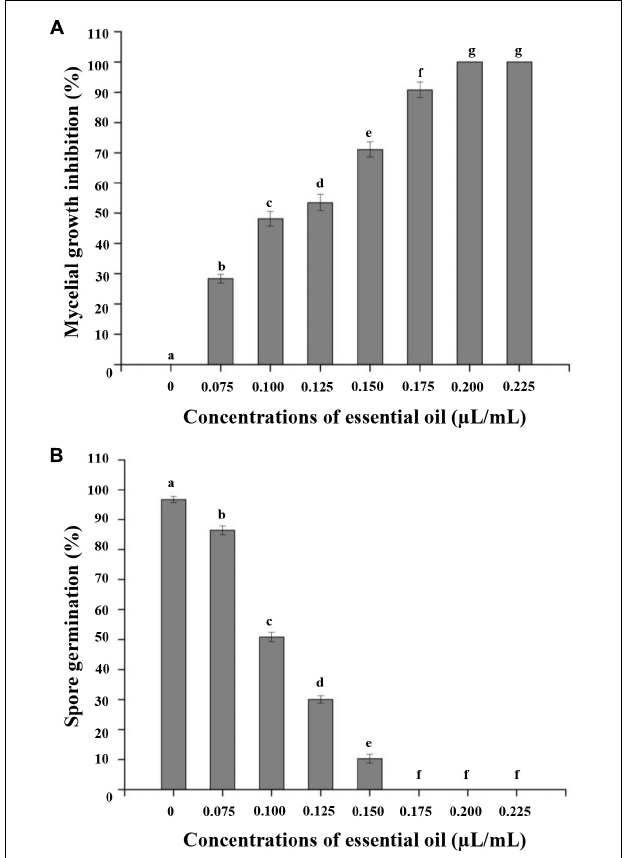
FIGURE 2 | Effect of different concentrations of CEO on mycelial growth (A) and spore germination (B) of C. acutatum. Values are the averages of the replicates for all the analyses. Error bars are ± SD of the means. In some cases the error bar is obscured by the symbol. Columns with different letters at each time point indicate significant differences according to Duncan’s multiple range tests at p < 0.05.